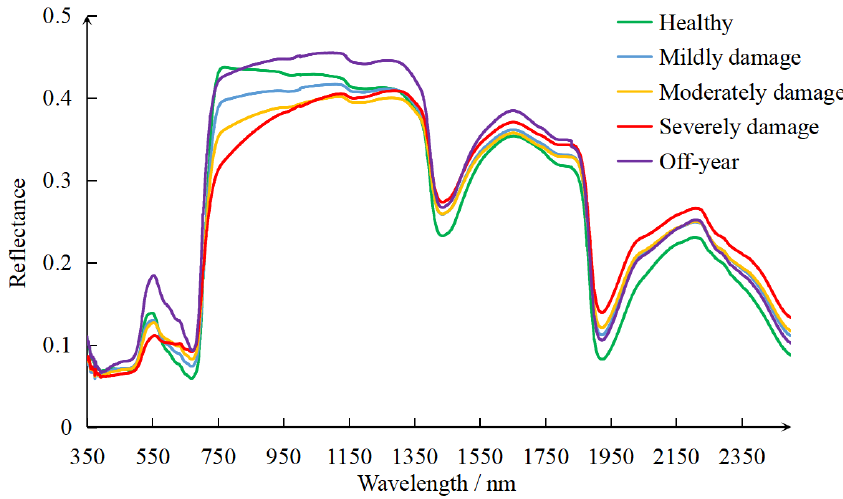
Figure 5. The mean reflectance values of moso bamboo leaves with different levels of damage severity calculated from measurements of 468 sampling leaves.